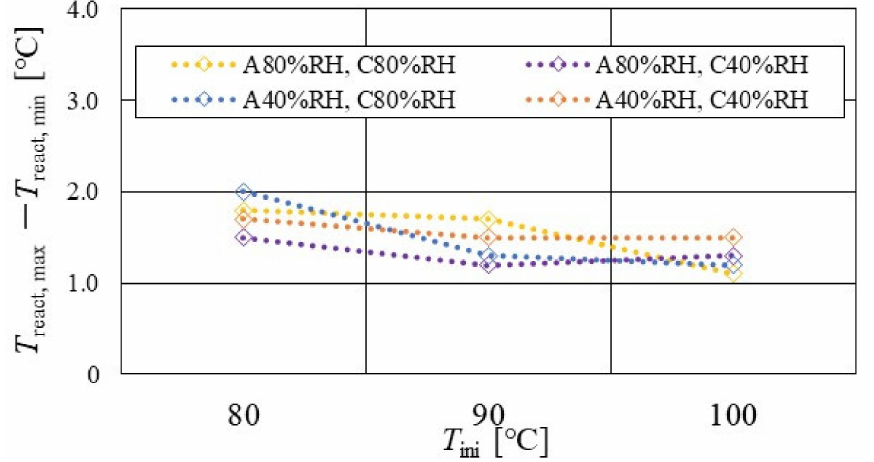
Figure 14. Effect of relative humidity and initial operation temperature and temperature difference, between the maximum and the minimum temperature in the distribution of temperature at reaction surface, for the separator thickness of 1.5 mm.